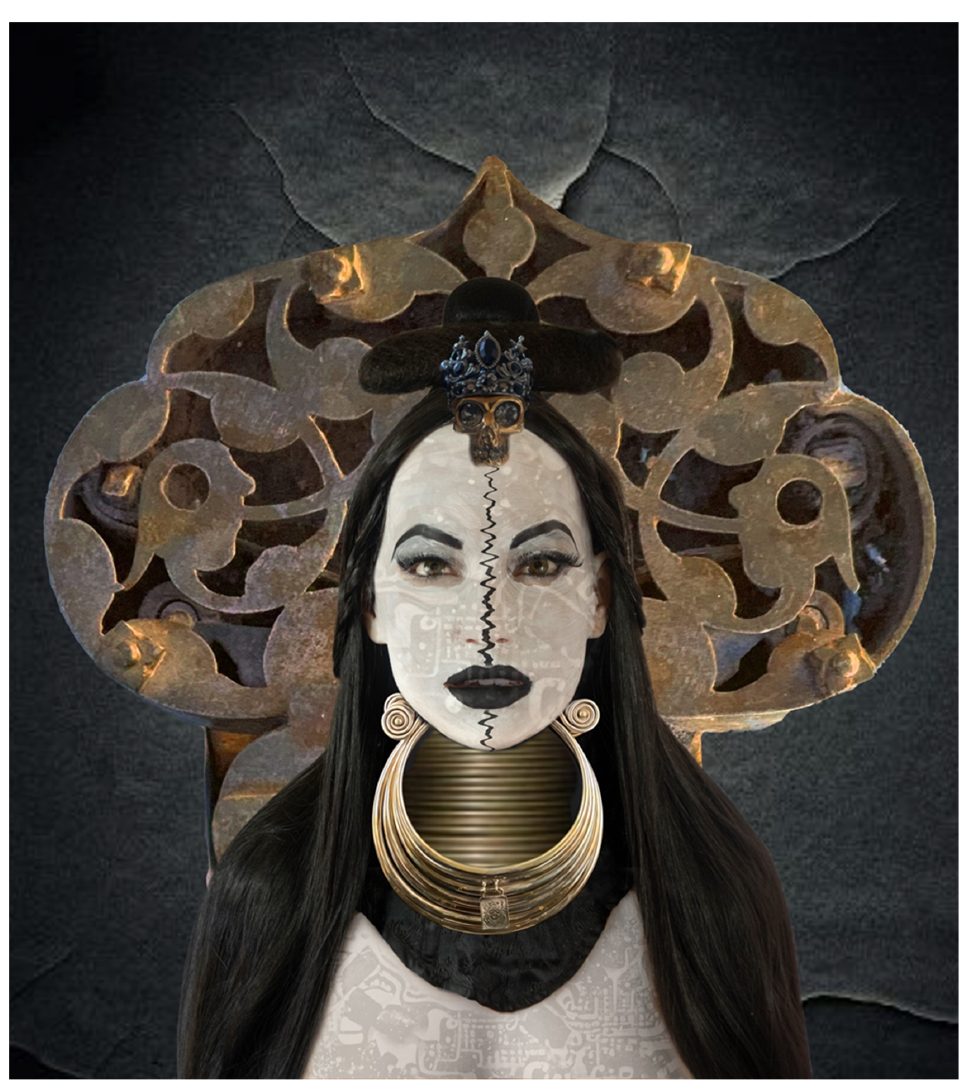
Figure 1. Madeleine + Computerization may allow us to transcend language entirely. By Graeme Revell, 2022. Photograph, GPT-2/DALL-E2 image and text.